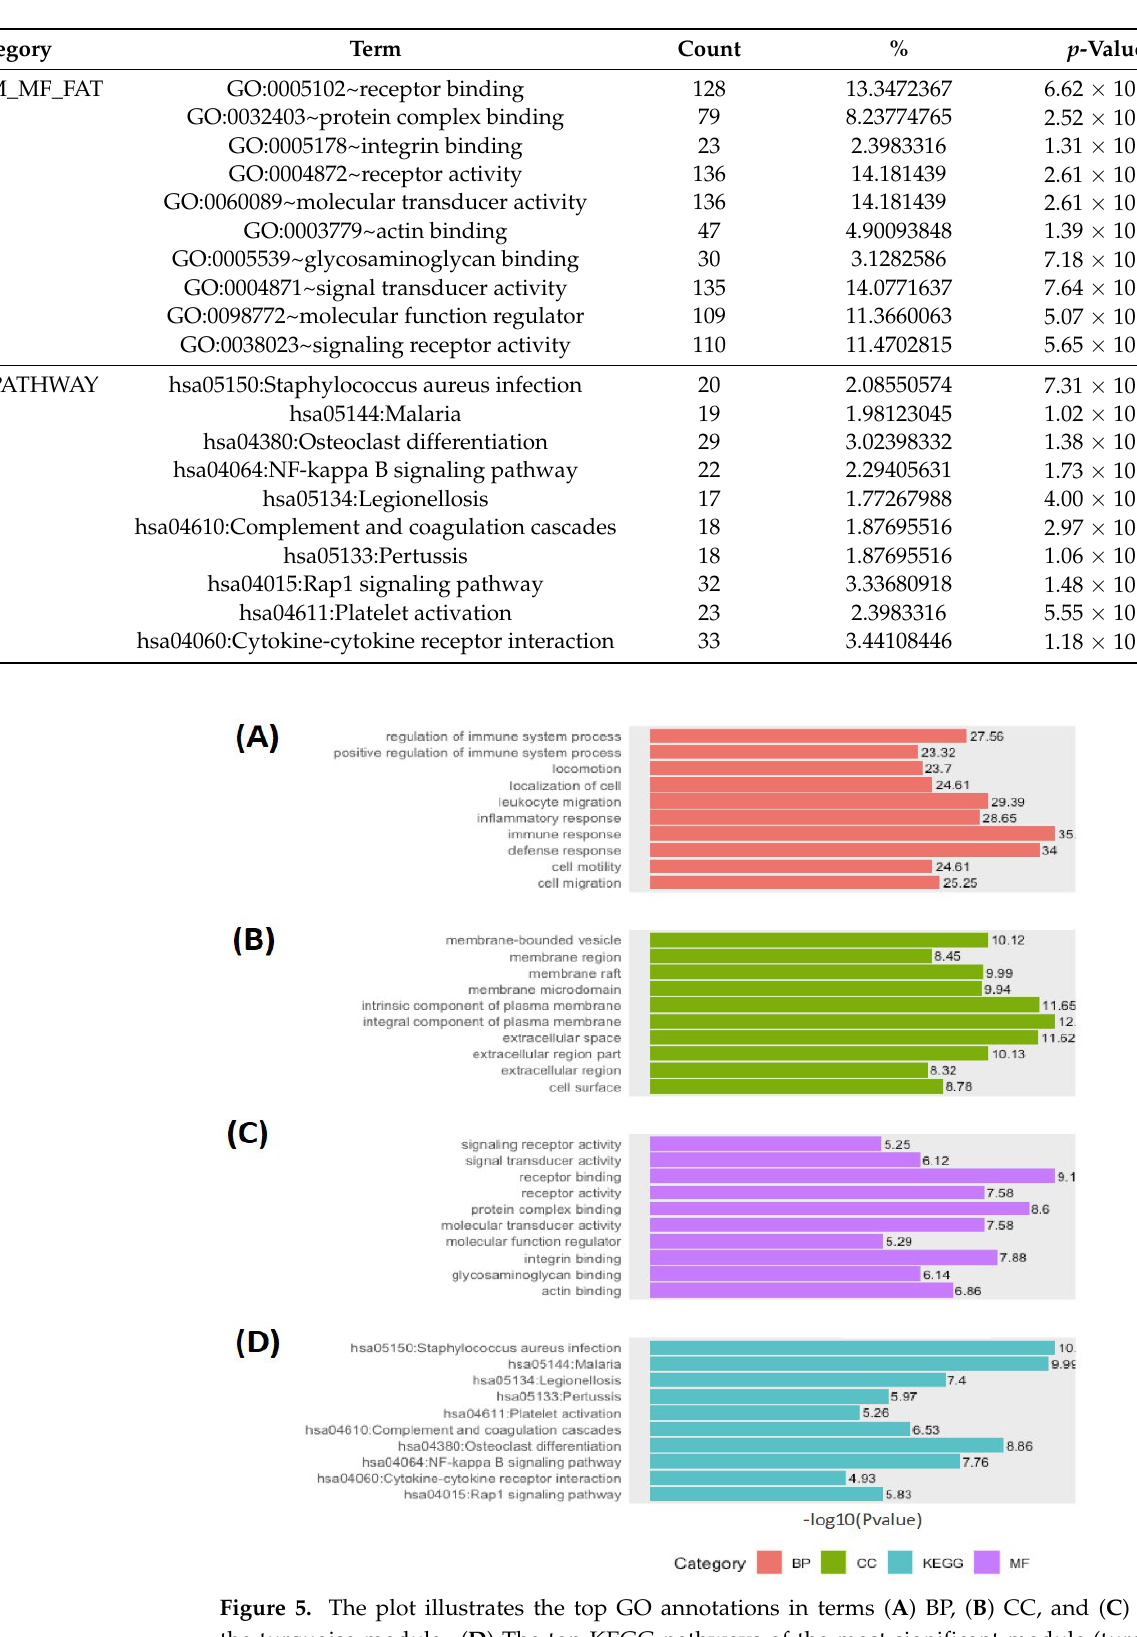
Figure 5. The plot illustrates the top GO annotations in terms ( A ) BP, ( B ) CC, and ( C ) MF of